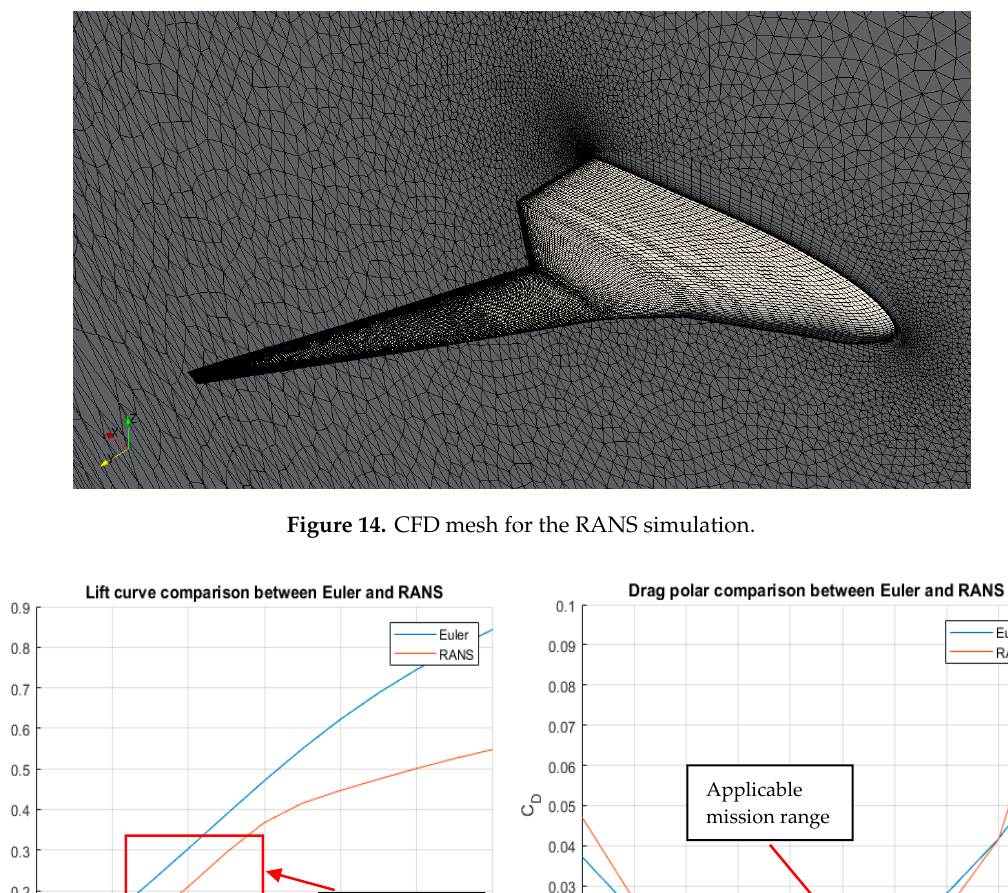
Figure 15. Aerodynamic performance comparison between RANS and Euler with the flat plate analogy for the skin friction